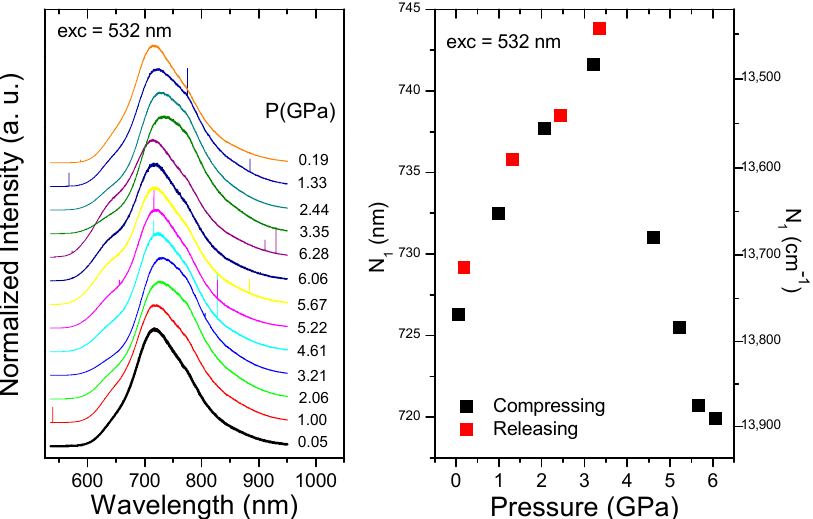
Figure 8. Pressure dependence of luminescence spectra of [(CuBr) 2 (Quin)] compound obtained at RT under 532 nm laser excitation ( left ), and pressure evolution of the centroid ( right ).